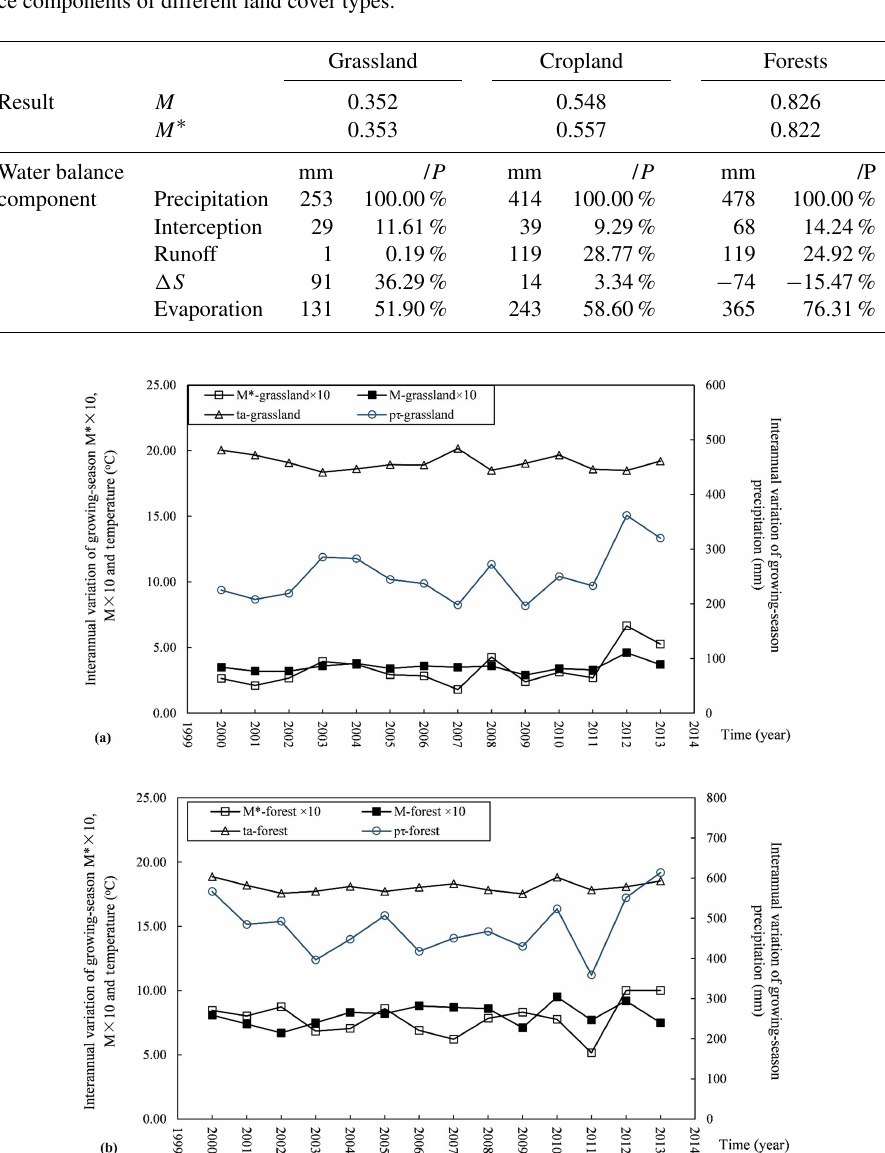
Figure 4. Variation of M ∗ , M , precipitation ( P τ ) and air temperature ( t a ) during 2000–2013: (a) grassland; (b) forest.